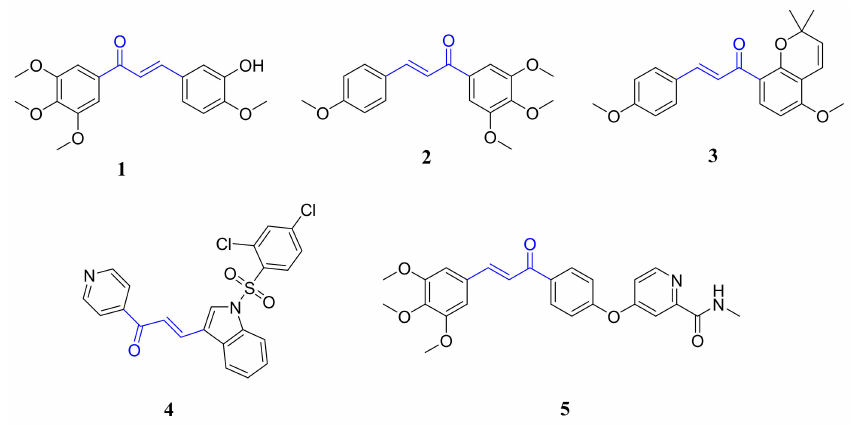
Figure 1. Structures of chalcone derivates as antitumor agents previously